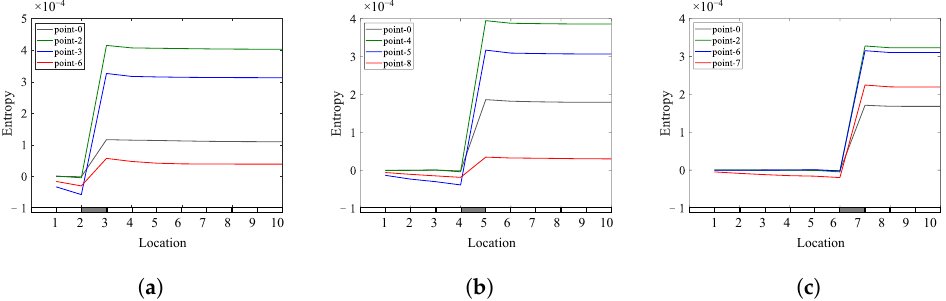
Figure 28. The effect of changing excitation locations on the Shannon entropy of a cantilever beam with a single breathing crack: ( a ) q 1 = 0.25; ( b ) q 2 = 0.45; ( c ) q 3 =